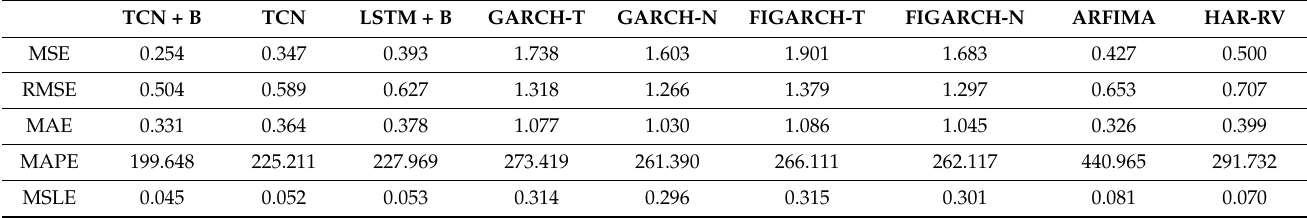
Table 8. Prediction error of each model (step size is 1). FIGARCH-T FIGARCH-N ARFIMA HAR-RV